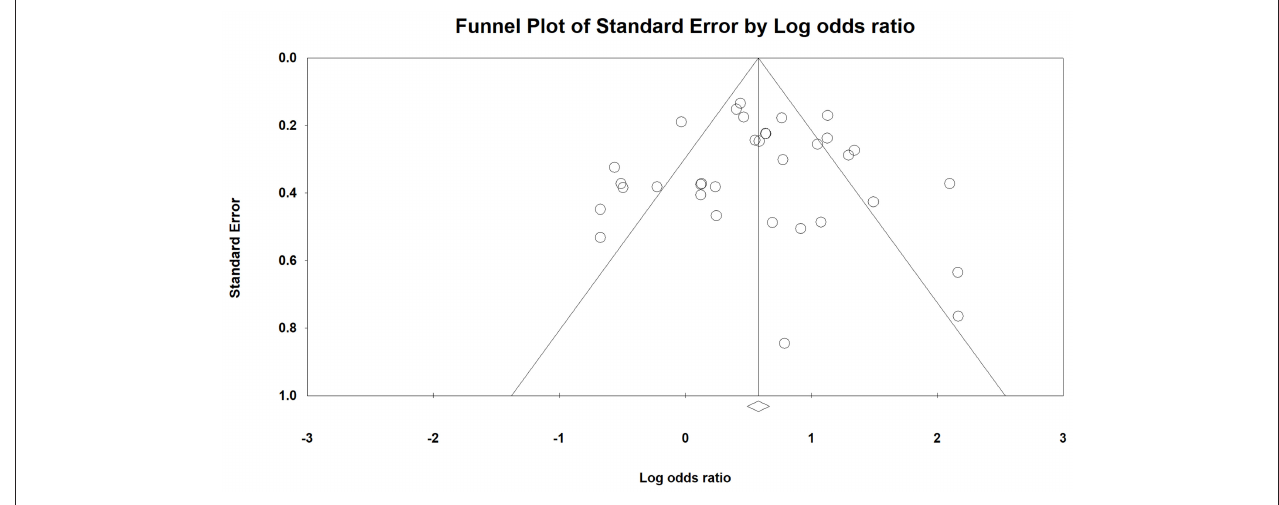
FIGURE 3 | Funnel plot based on ORs of included studies. ORs, odds